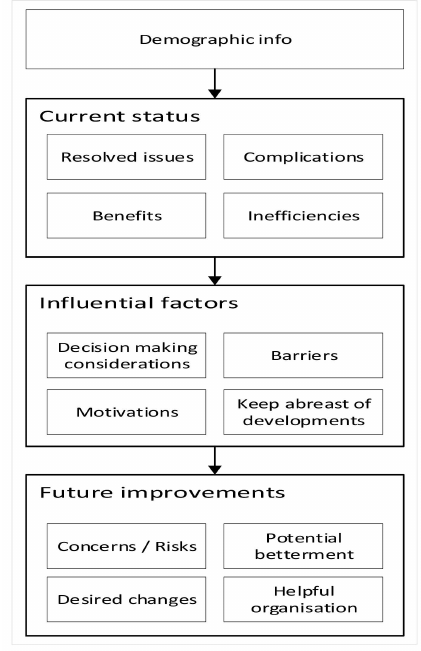
Figure 4. Structure of the